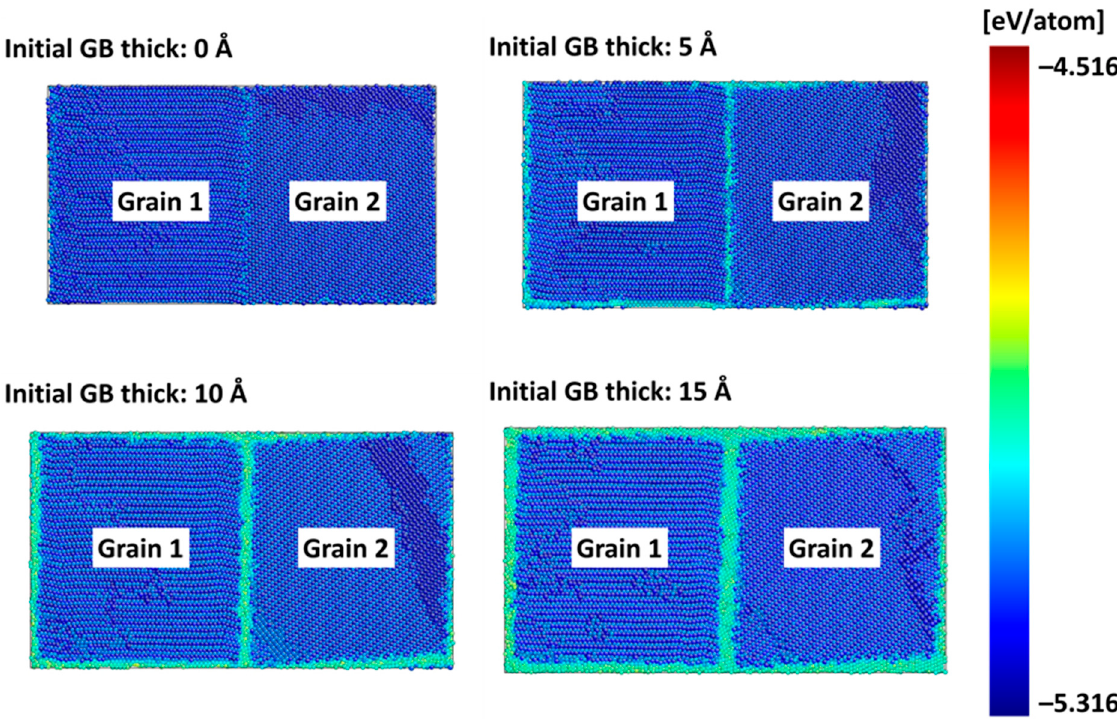
Figure 9. Simulation domains of BC with different initial grain boundary thicknesses. Atoms were colored by their potential energy.